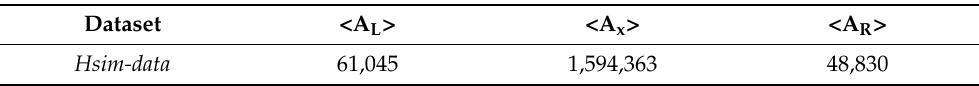
Table 7. False discovery rate (FDR) and true discovery rate (TDR) on sHSim-data—best results are in bold. Img Met. Table 6. Average hair area values on the HSim-data to compare with < AI > = 42648—best results are in